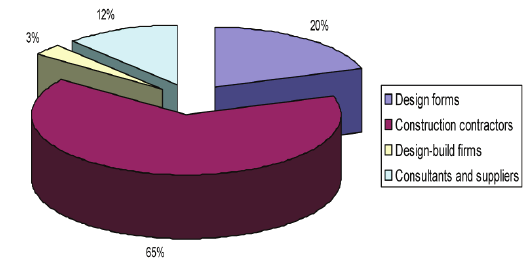
Fig. 3. Structure of enterprises according to business